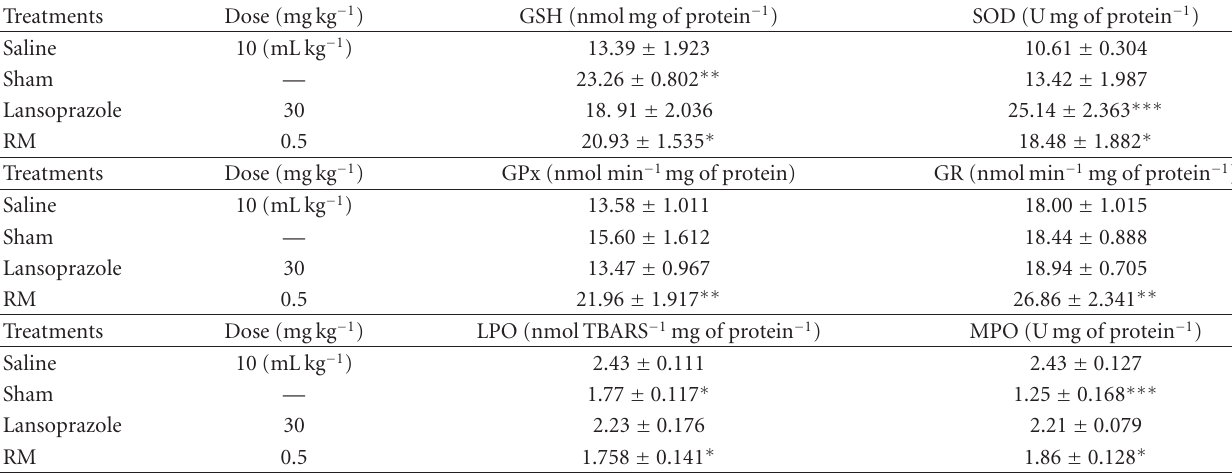
Table 3: E ff ect of RM on the antioxidant compounds and enzymes in ischemia-reperfusion-induced gastric ulcer in rats.